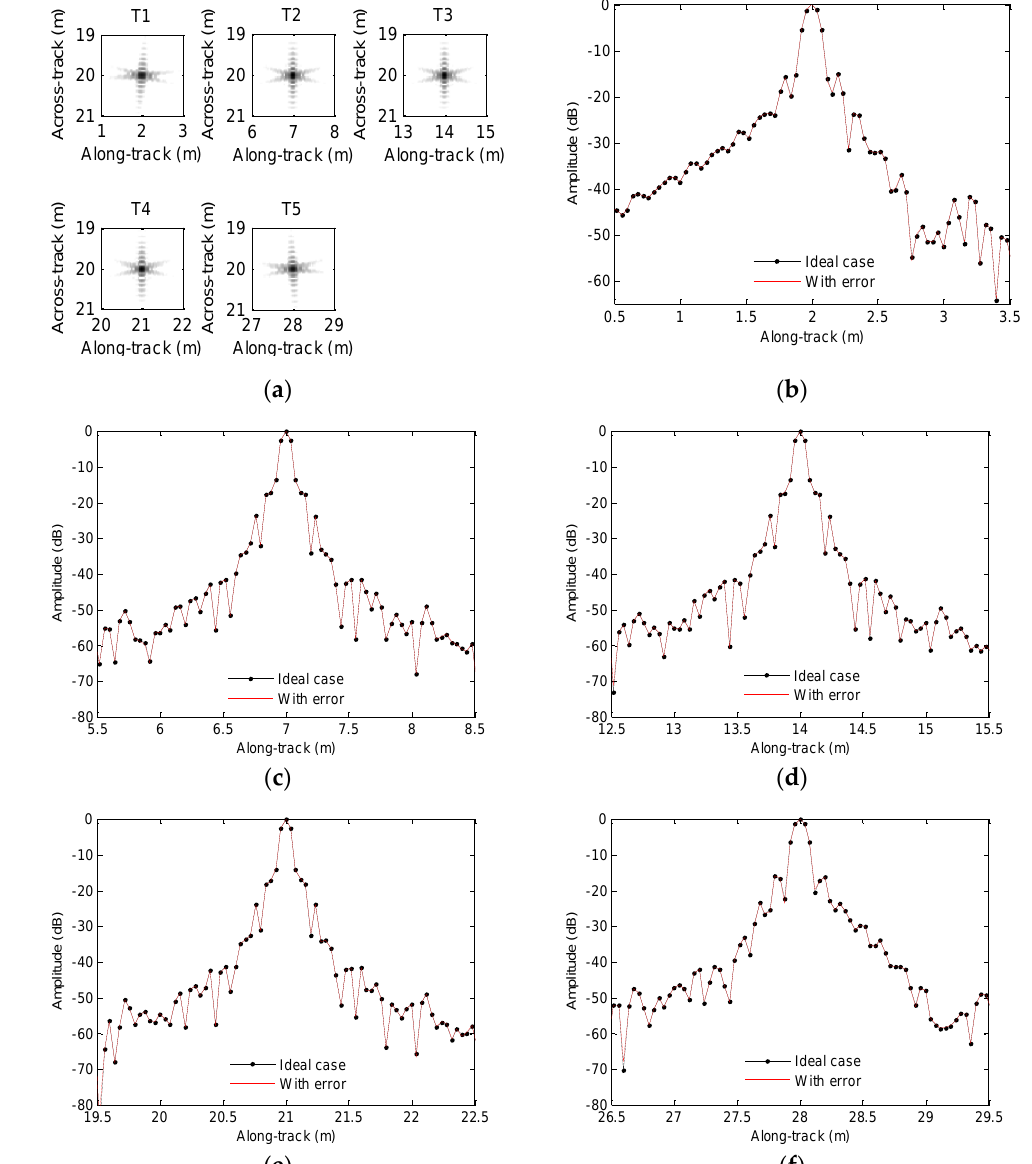
Figure 8. Processing results with the sinusoidal sway: ( a ) imaging result; ( b ) slice of T1; ( c ) slice of T2; ( d ) slice of T3; ( e ) slice of T4; ( f ) slice of T5. The peak sidelobe level ratio (PSLR), the integral sidelobe level ratio (ISLR) and deviation of along-track coordinates (DAC) are exploited to quantitatively evaluate the imaging performance. Table 2 lists the quality parameters for the two aforementioned experiments.